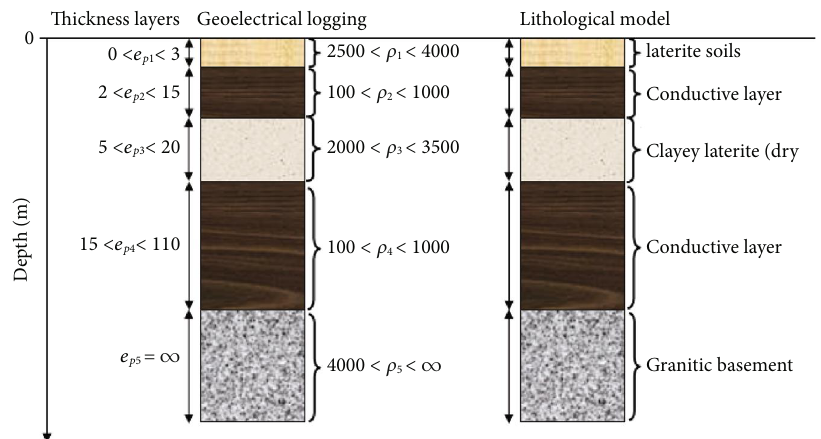
Figure 26: Lithological model of the sounding curves of type HKH.